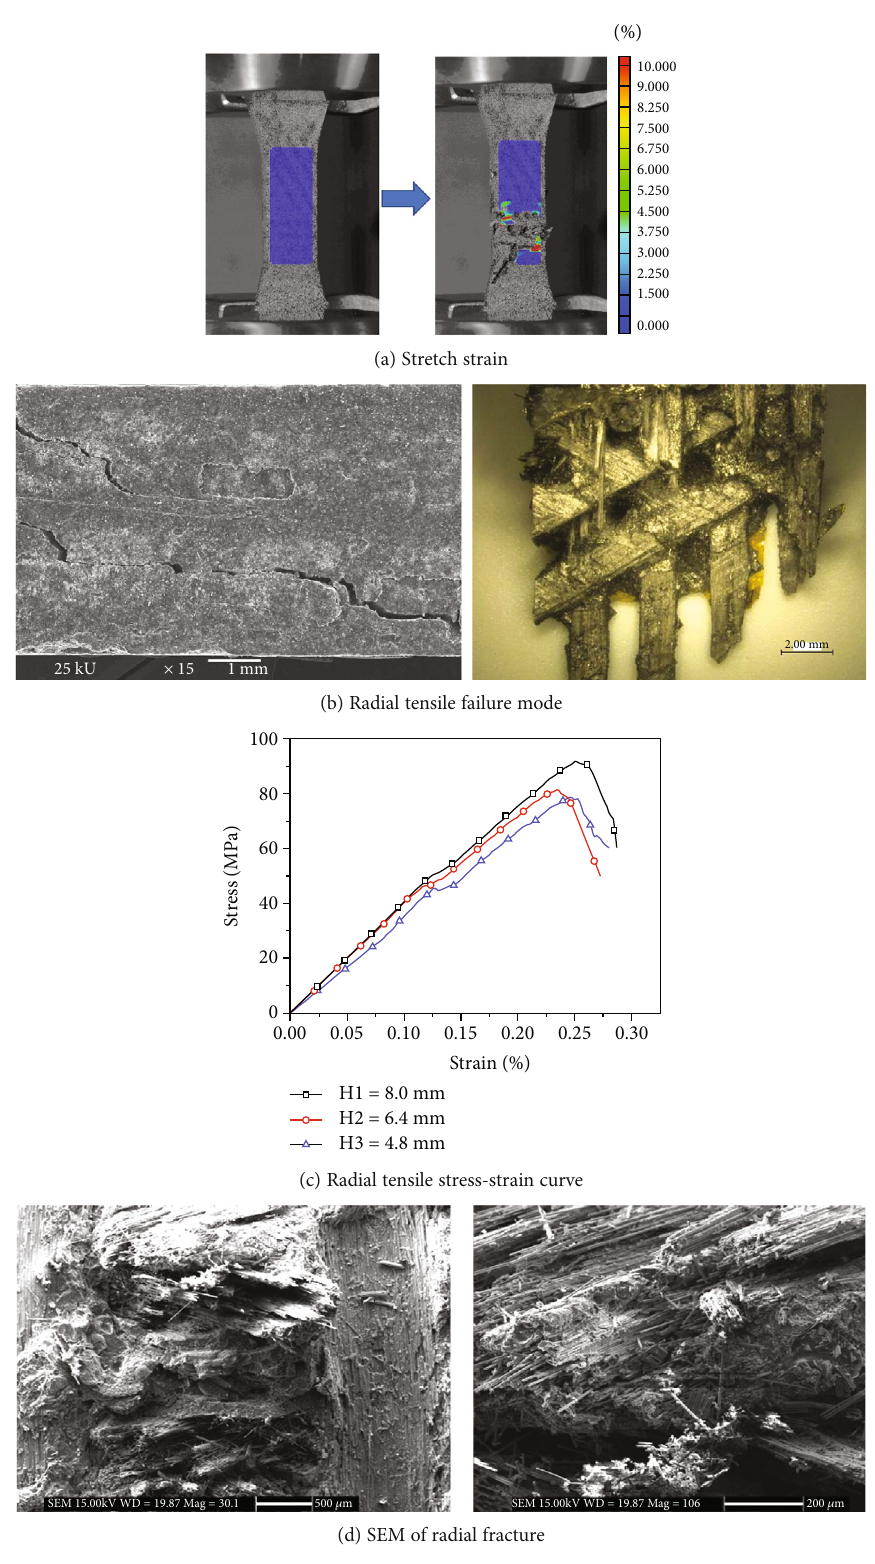
Figure 7: Radial tensile test